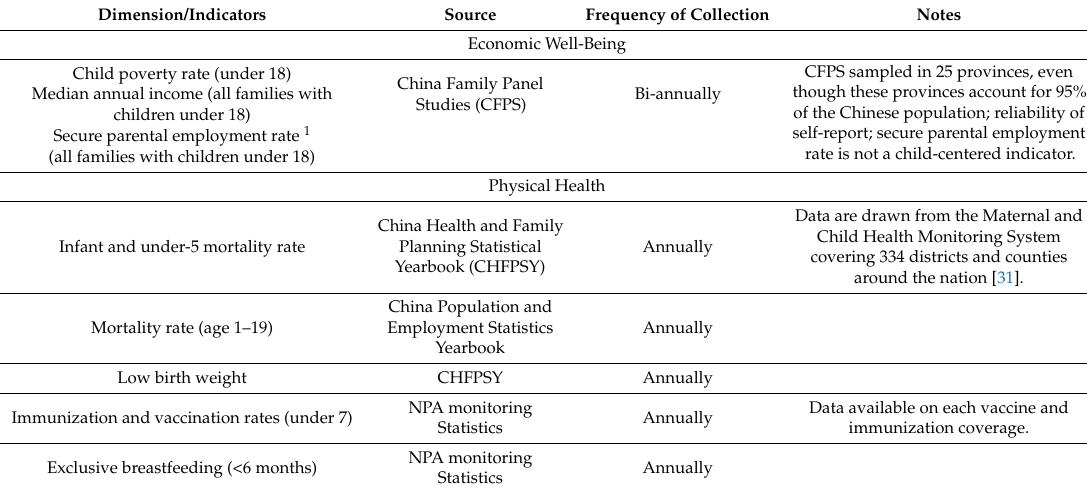
Table 2. China child well-being index: Indicators, potential sources, and